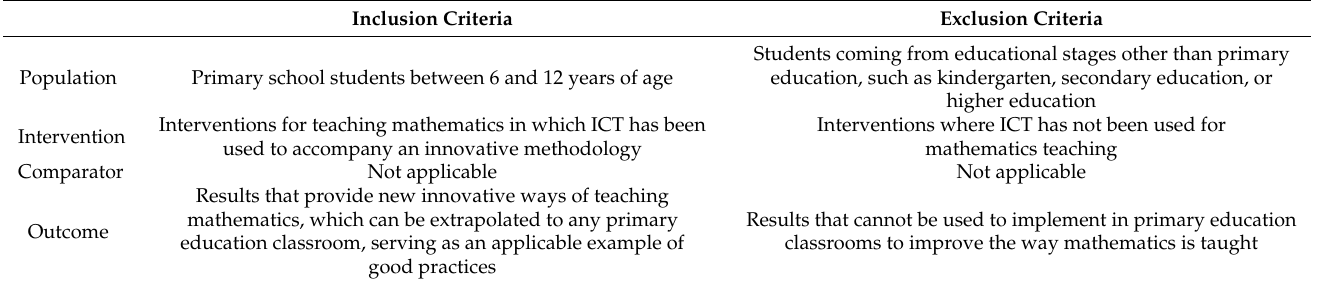
Table 1. Inclusion and exclusion